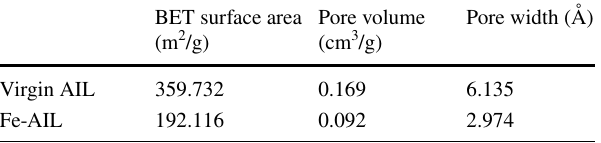
Table 4 BET results of virgin AIL and Fe-AIL BET surface area (m 2 /g)